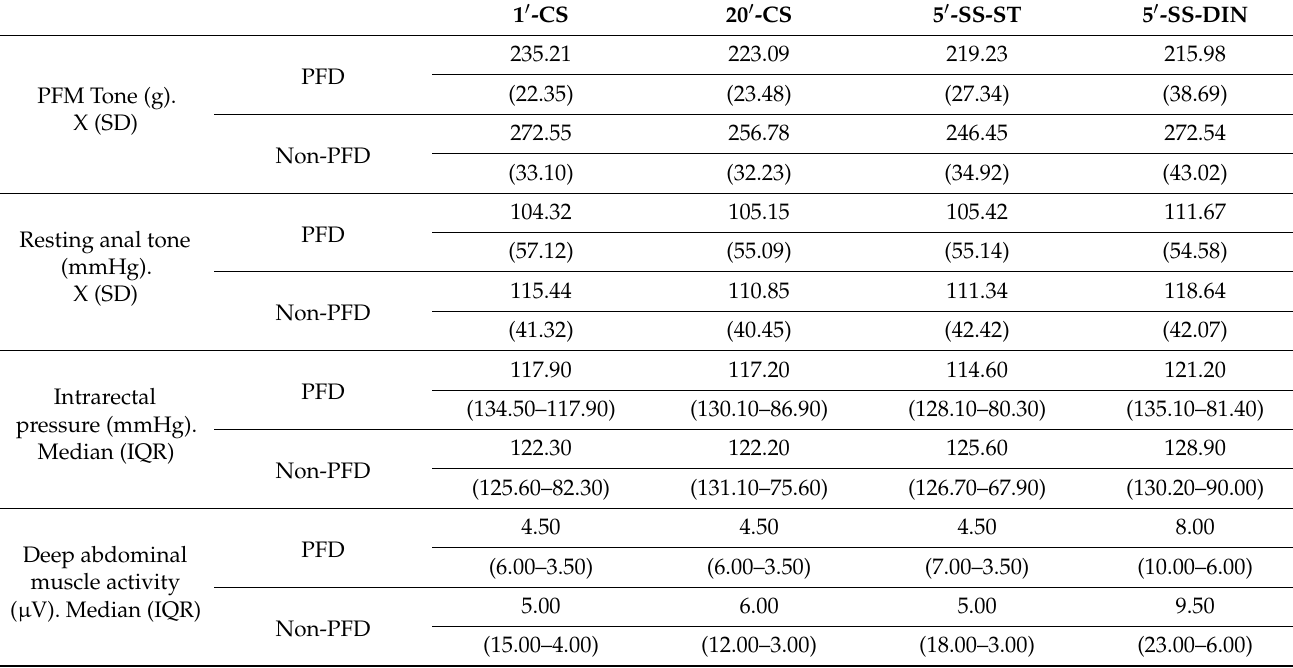
Table 3. Intragroup differences in pelvic floor muscles tone and resting anal tone across a single 5P ® LOGSURF